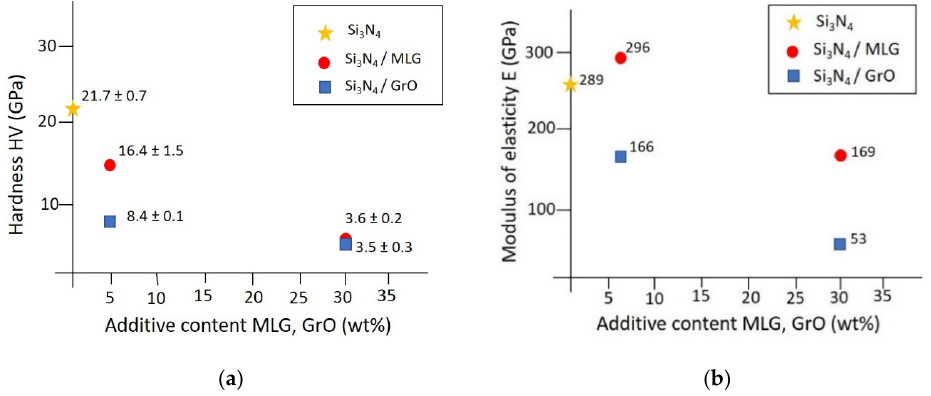
Figure 3. Mechanical properties of Si 3 N 4 -based composites. ( a ) hardness, ( b ) modulus of elasticity.